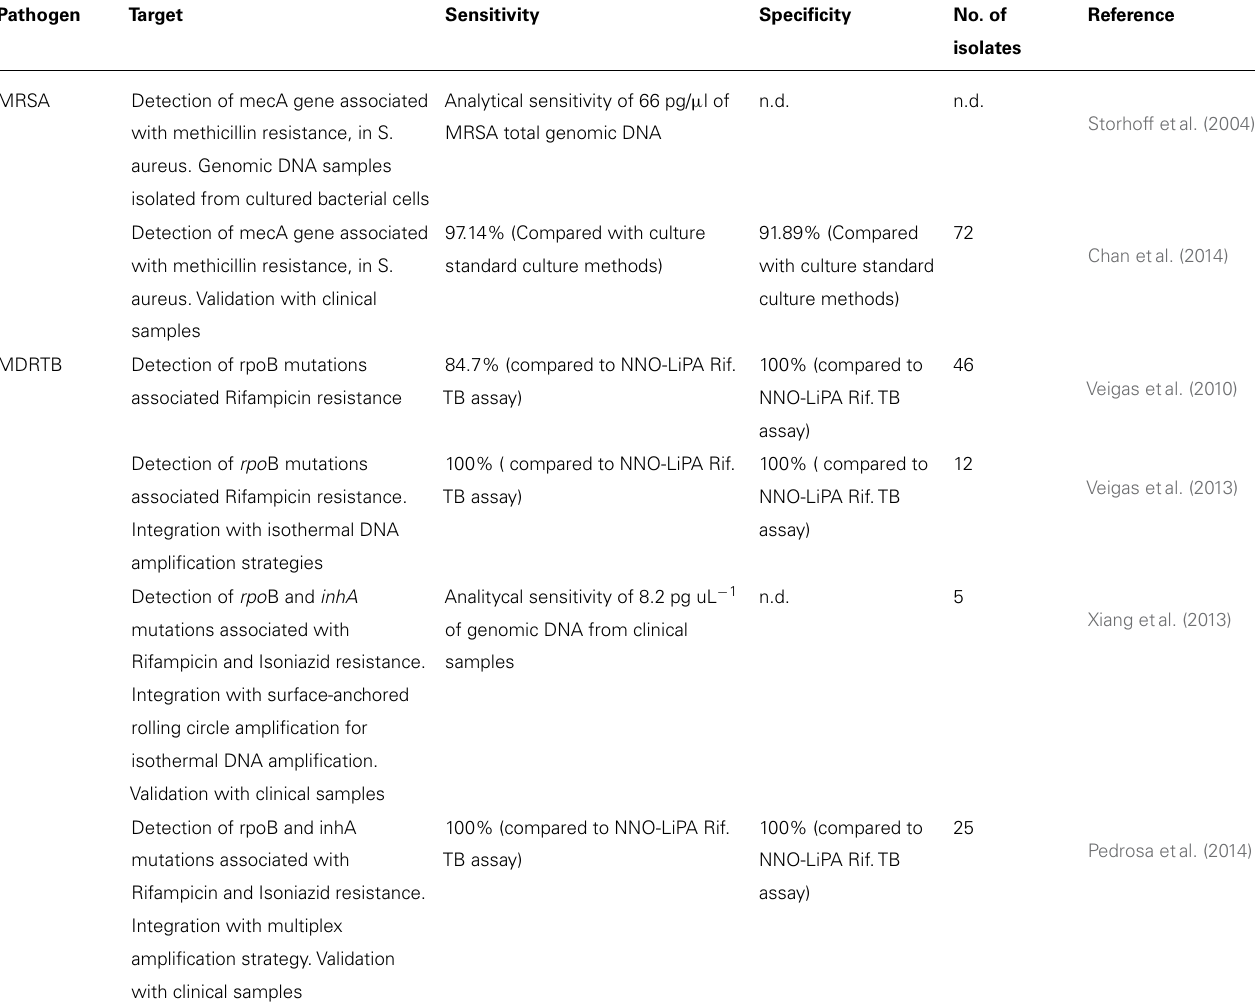
Table 2 |AuNPs-based systems for pathogen antibiotic susceptibility characterization, preclinical/clinical metadata of sensitivity and specificity.